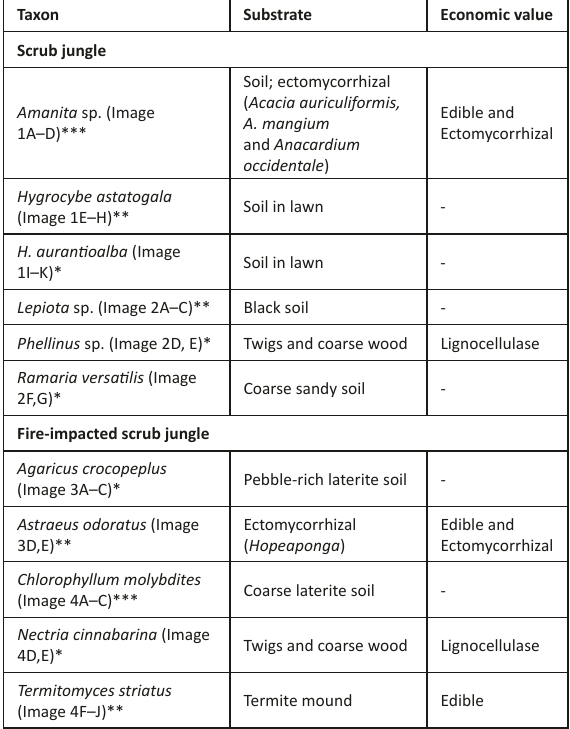
Table 1. Macrofungi recorded in scrub jungles of the western coast of